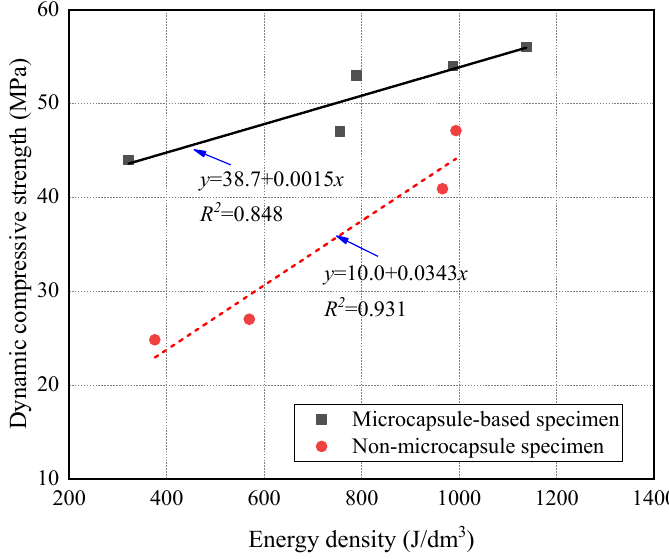
Figure 12. Relationship between dynamic compressive strength and energy density.